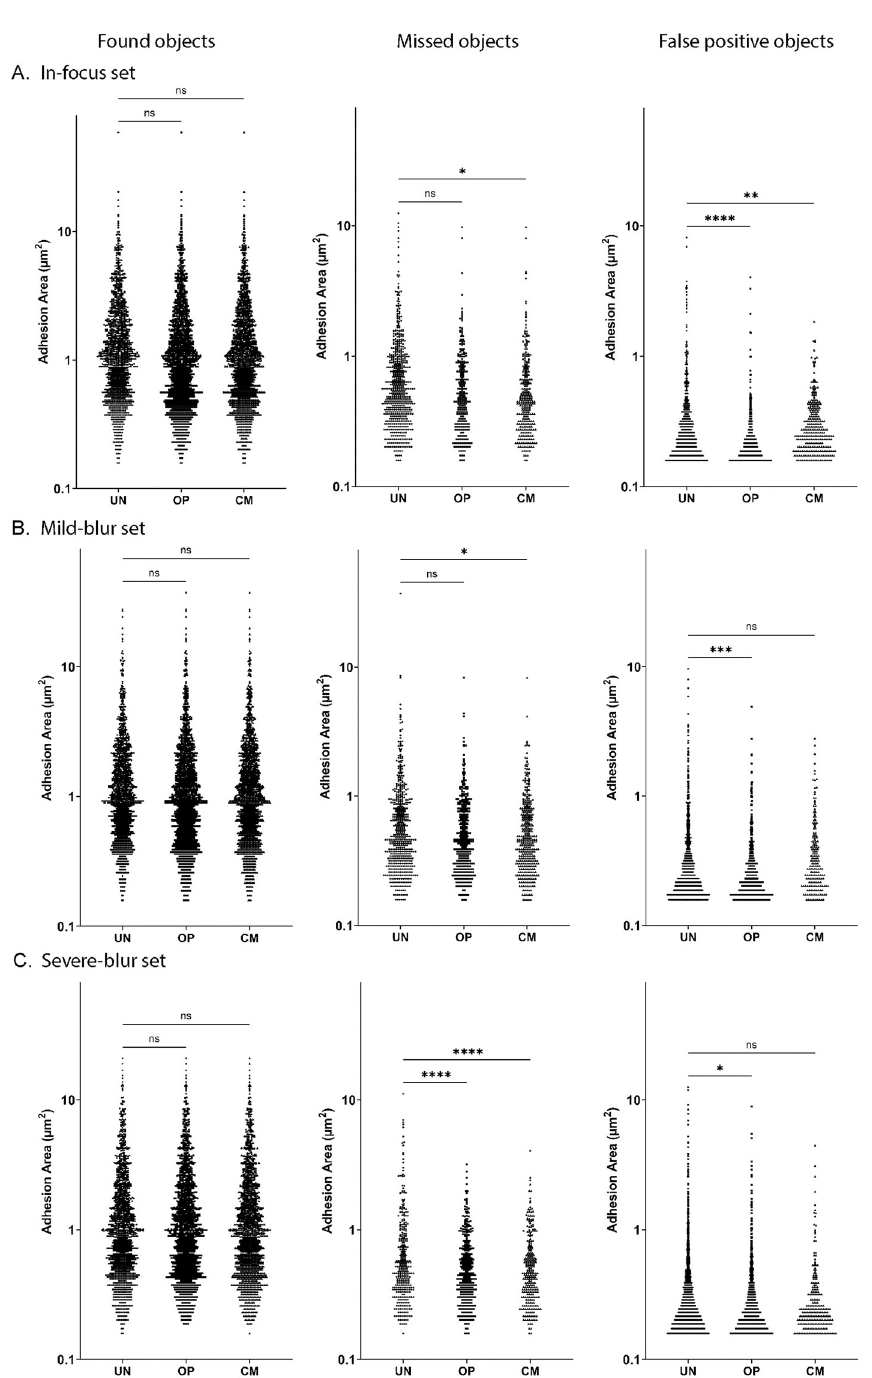
Fig 6. Comparison of adhesion objects between optimization levels in a set. Graphs show pooled adhesion objects for un-optimized ‘UN’, optimized ‘OP’ and customized ‘CM’ analysis. Y axis has adhesion area in μ m 2 on a logarithmic scale. Left column shows graphs comparing adhesion objects found in common between user mask and software output. Middle column shows adhesion objects that were missed in output and present only in user mask. Right column shows adhesion objects that are false positive, present only in the software output. A) Graphs for in- focus set B) Graphs for mild-blur set C) Graphs for severe-blur set. ���� p < 0.0001; ��� p < 0.001; �� p < 0.01; � p < 0.05 and ns stands for not significant (p >